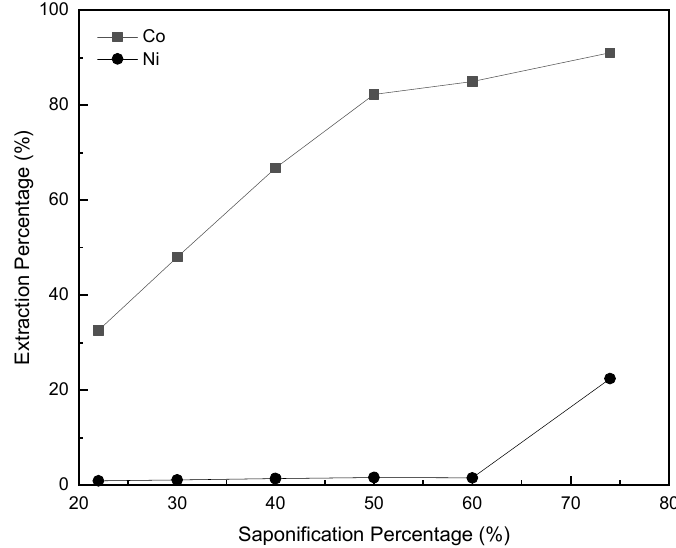
Figure 10. Extraction tendency of cobalt and nickel corresponding to saponification percentage. P-507/heptane—1:4 v/v ; complexing reagent—ammonium thiocyanate; O/A—1:1).